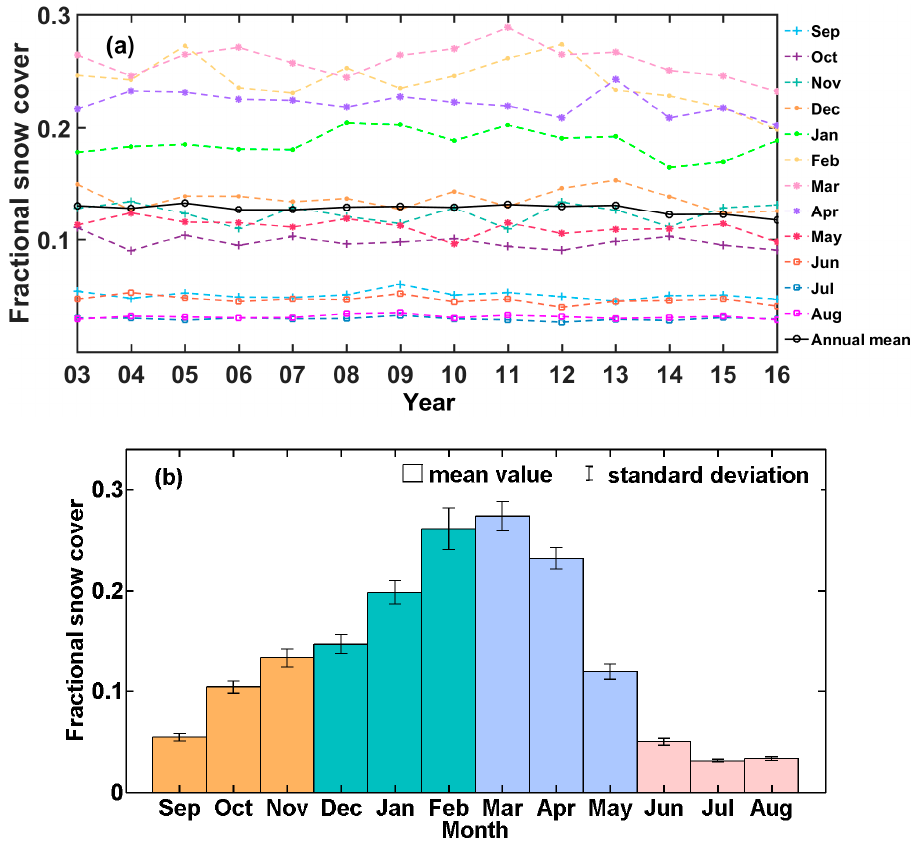
Figure 3. Fractional snow cover over the North Hemisphere Extratropical Land during 2003–2016: ( a ) monthly and annual mean; and ( b ) climatological monthly mean.